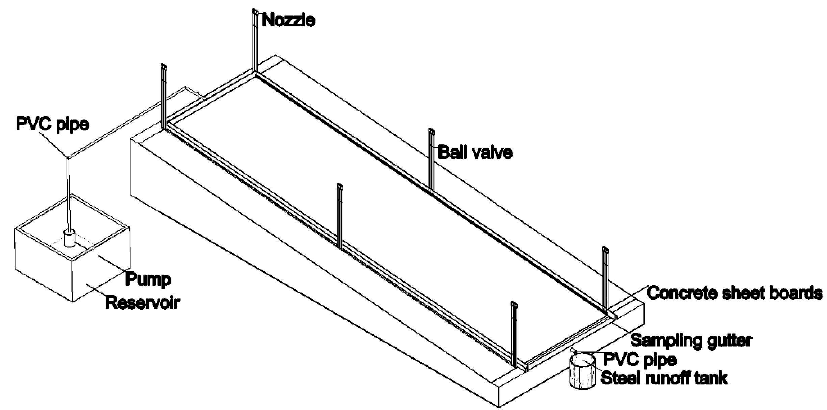
Figure 1. Sketch of the slope and simulated rainfall system.